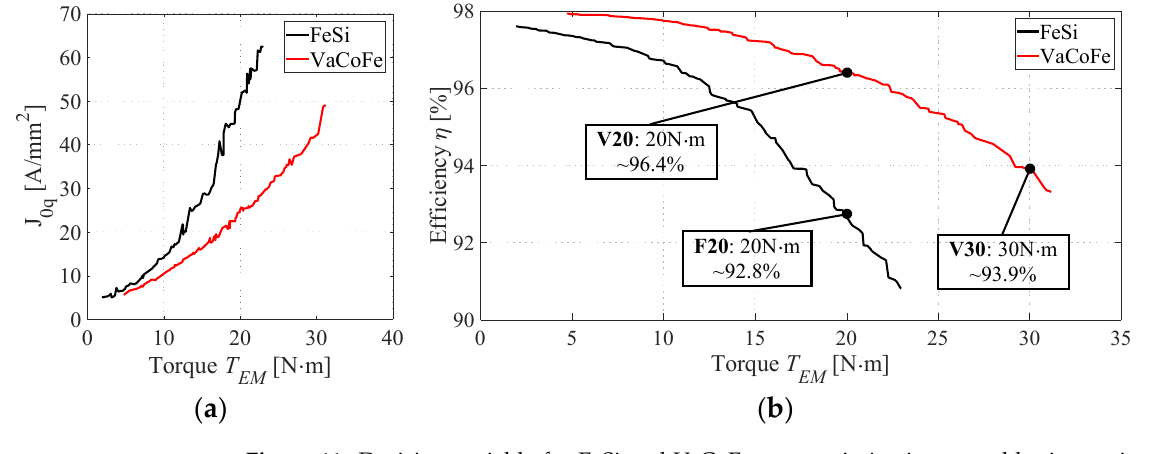
Figure 11. Decision variable for FeSi and VaCoFe core optimization sorted by increasing torque: ( a ) torque-producing current density J oq and ( b ) Pareto front with objective function efficiency and electromagnetic torque values of the last generation. Geometries selected for further analysis are represented.